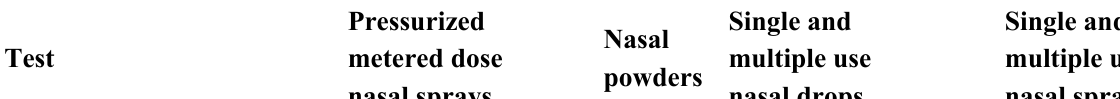
Table 1. Tests recommended for the finished drug product specification by the Food and Drug Administration (FDA) and the European Medicines Agency (EMA) (standard quality tests are not